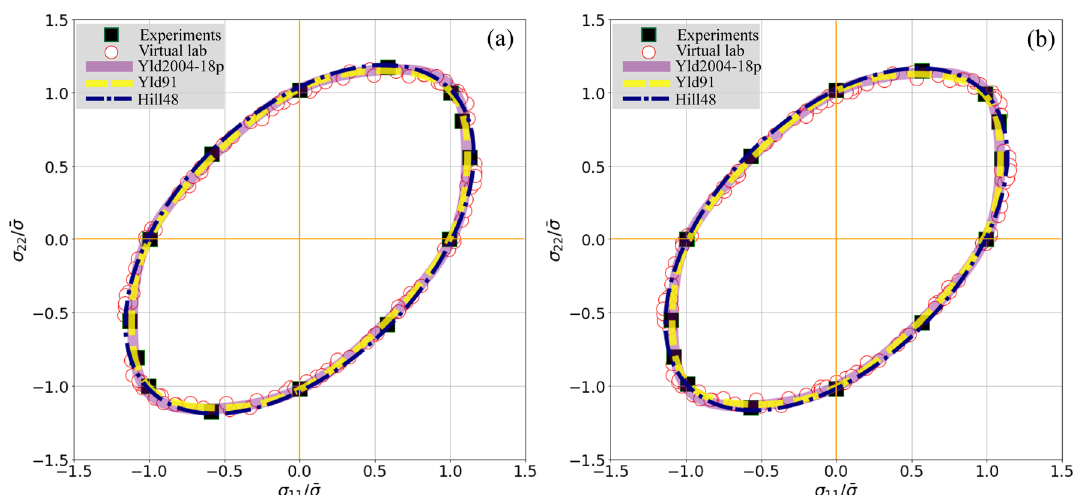
Figure 6. Yield loci (σ 12 = 0 ) of the DP980 sheet outlined by the experimental stress points (solid squares) of different loading conditions, enclosed by 60 random stress points (open circles) generated by the VL, and predicted by the calibrated yield functions (lines); the equivalent deformation stage with the specific plastic work of 3 MPa ( a ) and 8 MPa ( b ). ¯ σ denotes the uniaxial tensile stress in RD obtained from the virtual